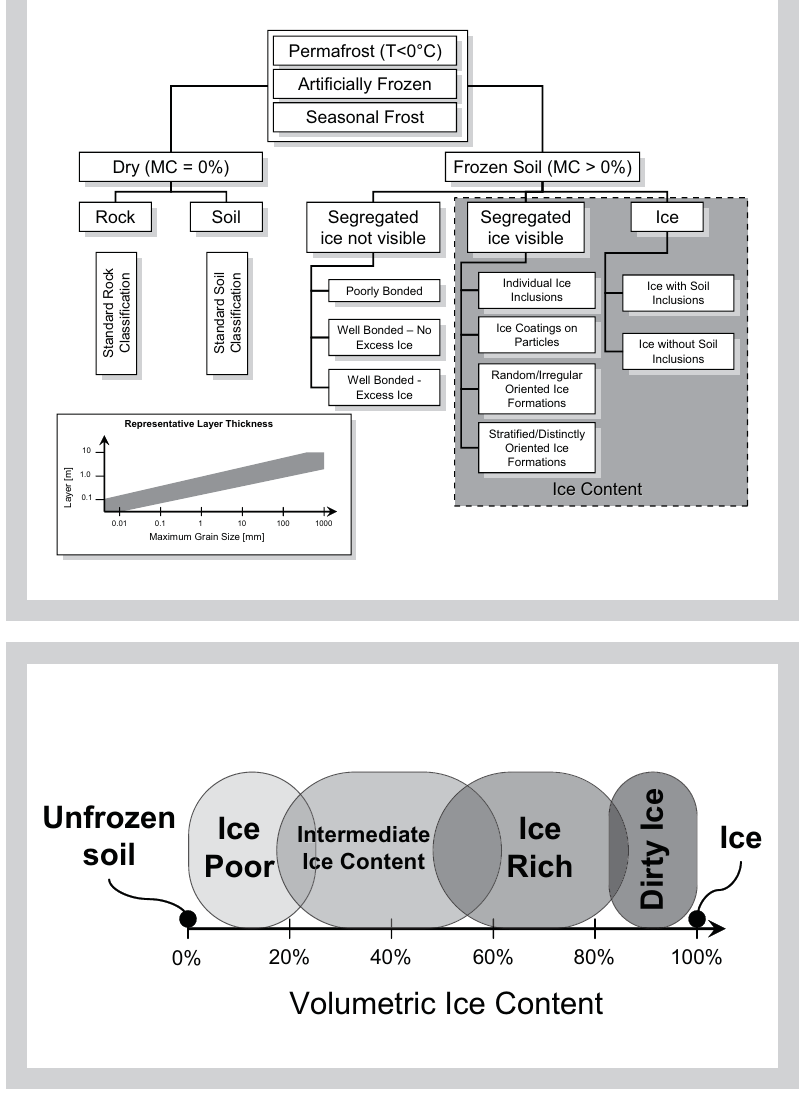
Figure 1: Soil classification for frozen soils and permafrost sam- ples (after [44] and [45]). Figure 2: Frozen soil classification according to the total volu- metric ice